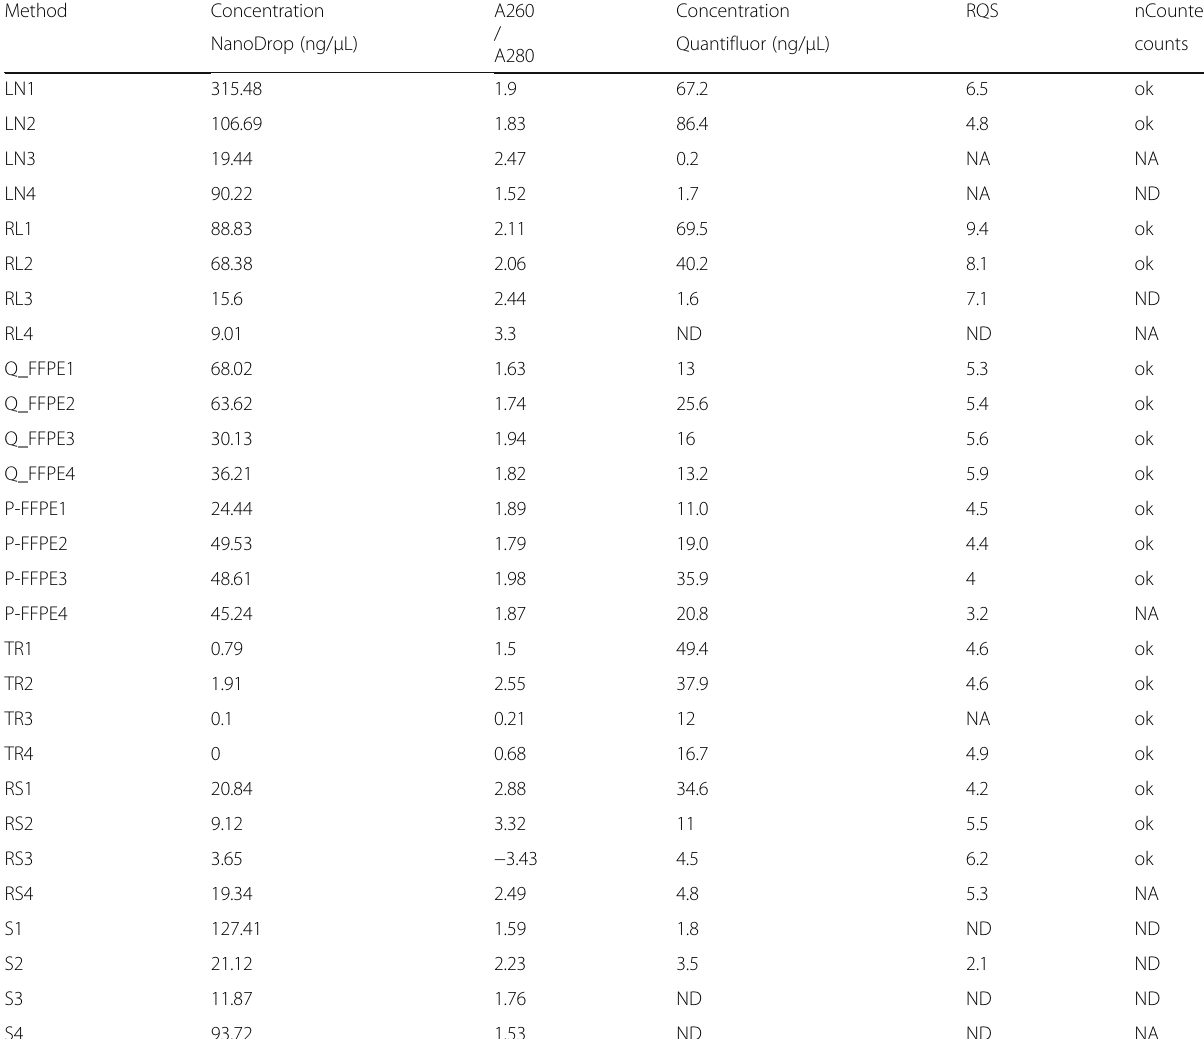
Table 1 RNA concentration and quality scores in the collected samples Method